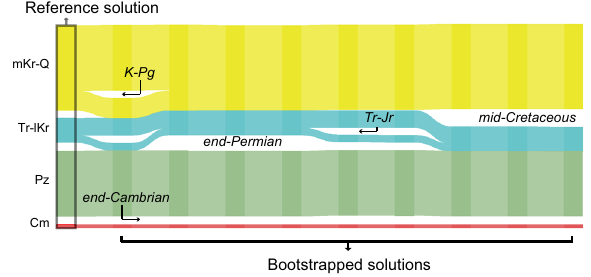
Fig. 4 The solution landscape. Alluvial diagram comparing the four-phase reference solution against alternative solutions obtained from bootstrapped networks. Vertical stacks connected by streamlines represent the networks. In each stack, a block represents nodes clustered into a module or mega- assemblage. Streamlines connect modules that contain the same nodes. The height of the streamline is proportional to the number of shared nodes between the connected modules. Splitting or merging streamlines indicate biotic transitions. The bootstrap strategy demonstrate high robustness of the four mega-assemblages in the reference solution (Supplementary Table 1), supporting the global biotic transitions delineated at the end-Cambrian, end- Permian, and mid-Cretaceous. The bootstrapped solutions also capture the small effect the Cretaceous – Paleogene extinction event (K – Pg) has on the mid-Cretaceous to Quaternary mega-assemblage (mKr-Q), and the instability of the global biosphere through the Triassic – Jurassic (Tr – Jr) extinction event (see Fig. 2). Cm Cambrian, Pz Paleozoic, Tr – lKr Triassic to lower Cretaceous, mKr – Q mid-Cretaceous to Quaternary mega-assemblages.